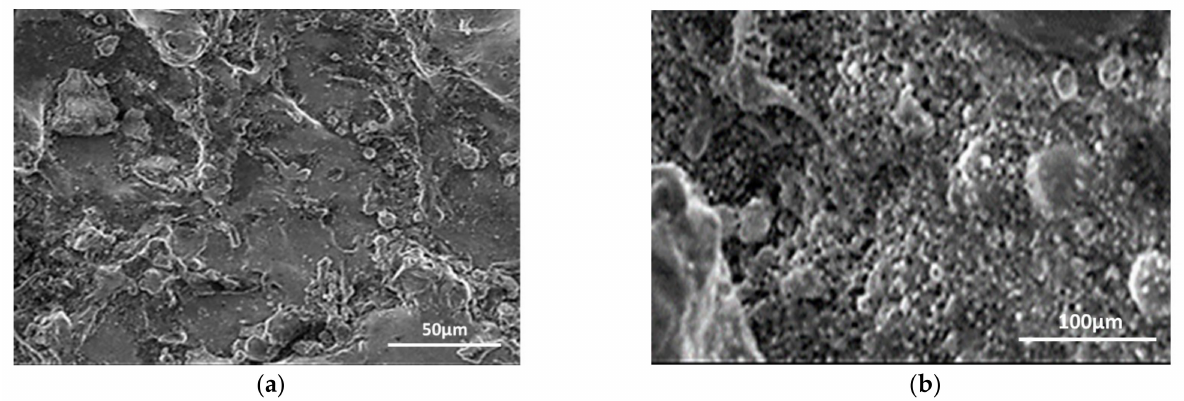
Figure 7. SEM of Al-Mg-0.6Si-0.35Fe/15%RHA/5%Cu hybrid metal matrix composite workpiece at ( a ) × 500 and ( b ) × 250 res. after wire-EDM.